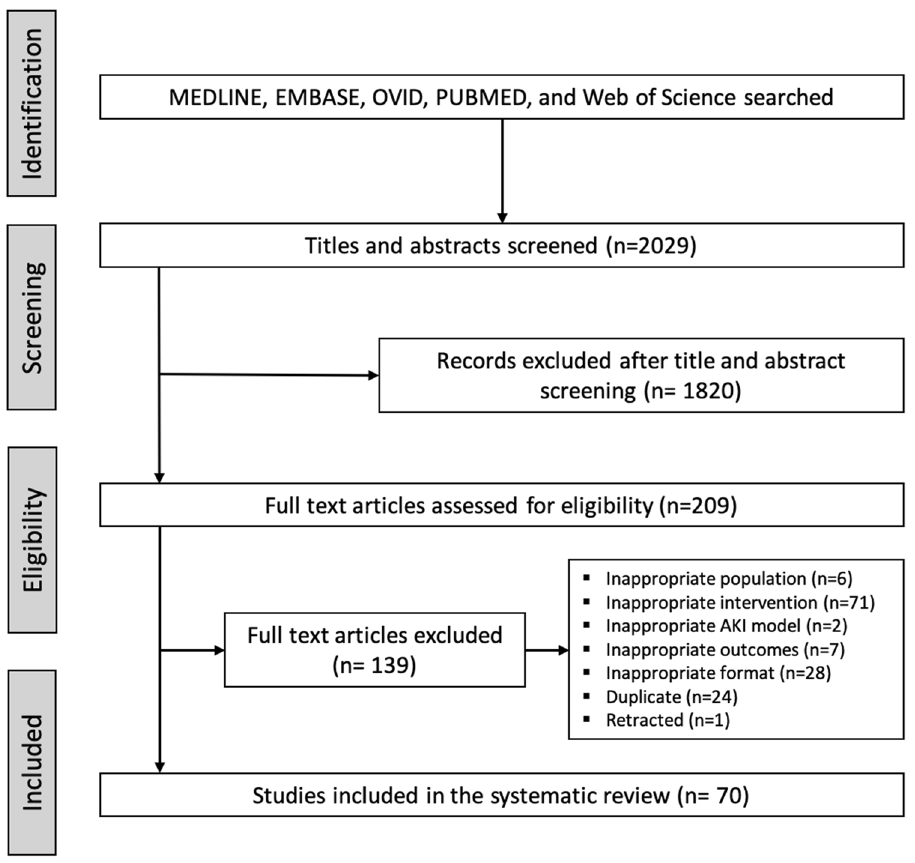
Figure 1. PRISMA flowchart. Number of titles, abstracts and full texts screened, resulting in 70 studies included in the qualitative synthesis. AKI = Acute kidney